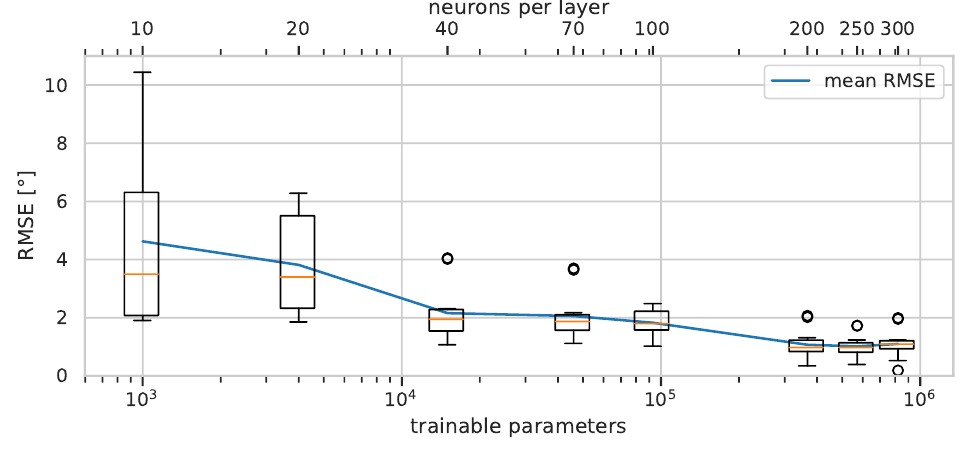
Figure 9. Performance of NN-TA for varying network size. Performance is quantified by box plots and the mean of the RMSE over all validation sequences. Increasing the network size leads to continuous performance improvements at the cost of an exponentially growing number of